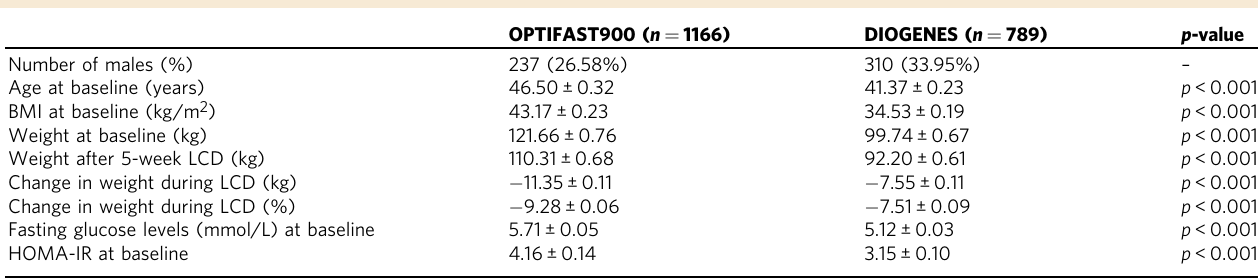
Table 1. Upon a 5-week low calorie diet (LCD), participants lost respectively for the Optifast900 and DiOGenes participants. At baseline, Optifast900 participants were considered more insulin- Table 1 Descriptive statistics for the two studies used in the